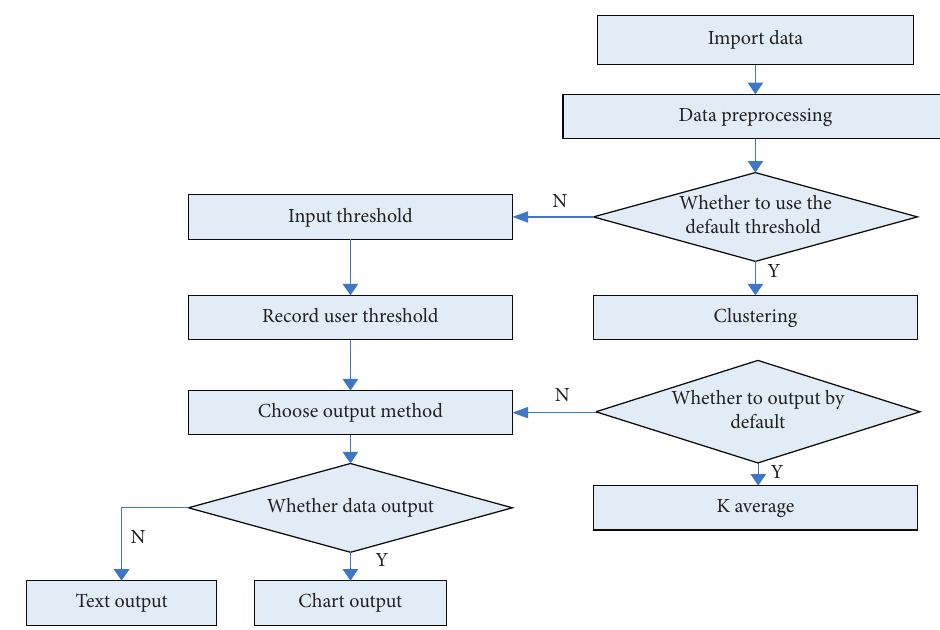
Figure 6: System operation flow chart. Table 1: Experimental